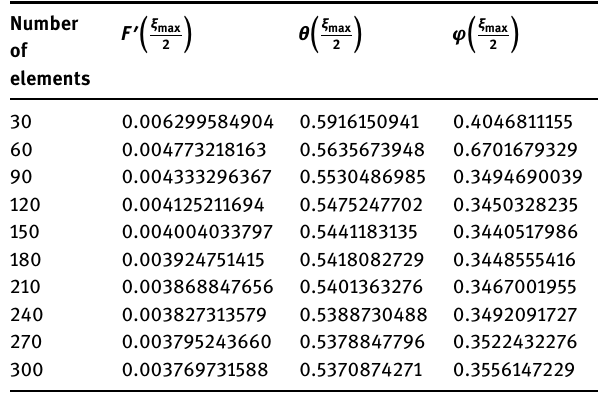
Table 2: Mesh - free study for temperature gradient, concentration gradient, and Sherwood number via 300 elements